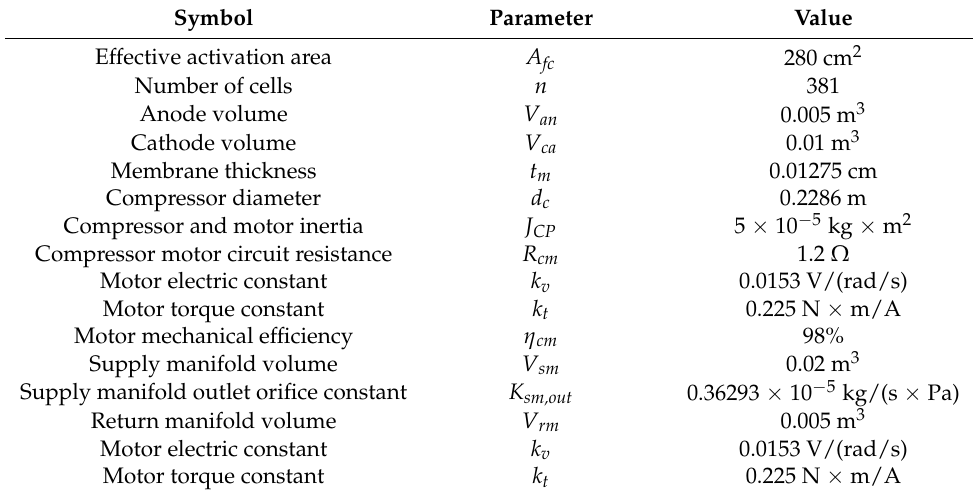
Table 1. Fuel cell model parameters. Developed with permission from Springer-Verlag London 2004, 2021 [22].